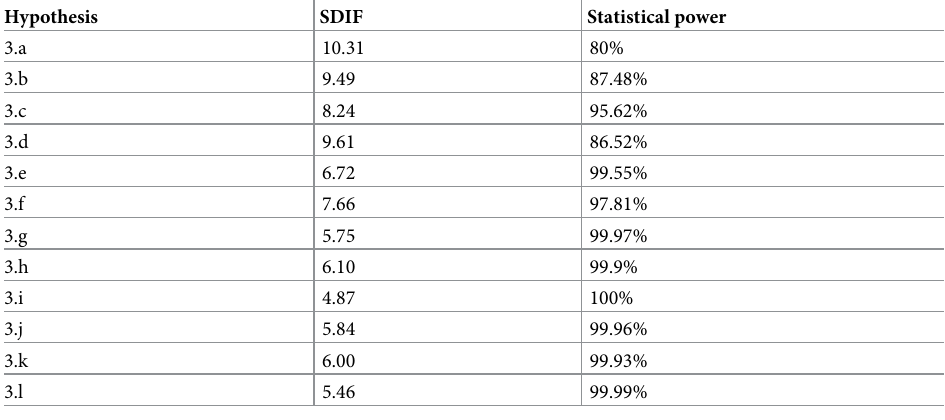
Note . SDIF = Standard deviation of the difference.